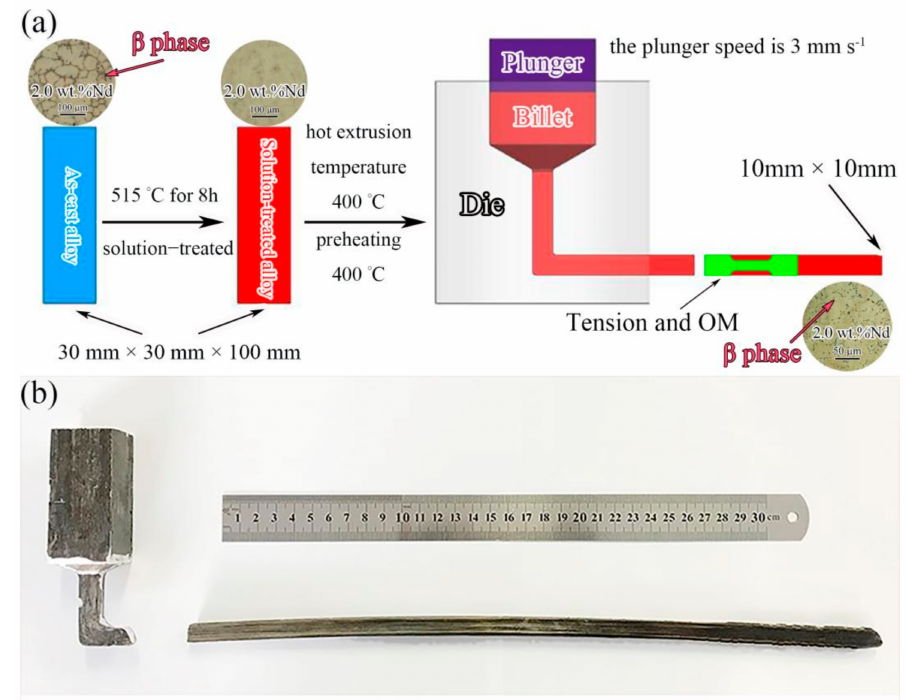
Figure 1. IEECAP process ( a ) and macrograph of the IEECAPed sample ( b